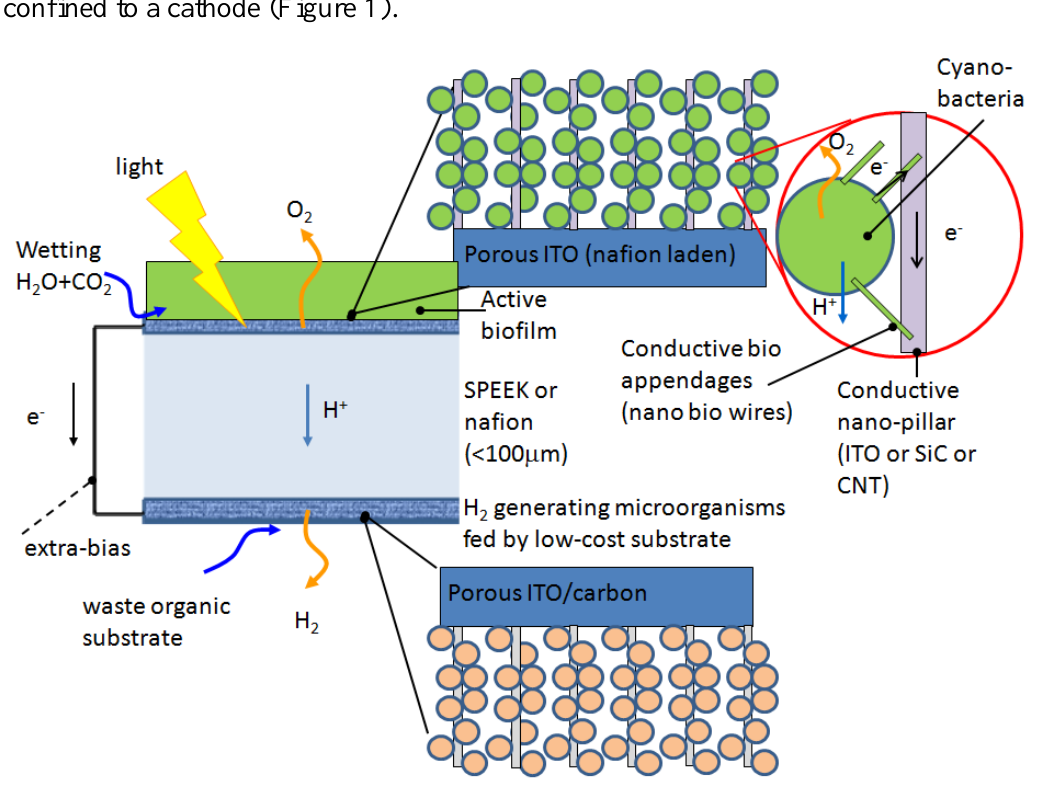
Figure 1. The photosynthetic microbial electrochemical cell